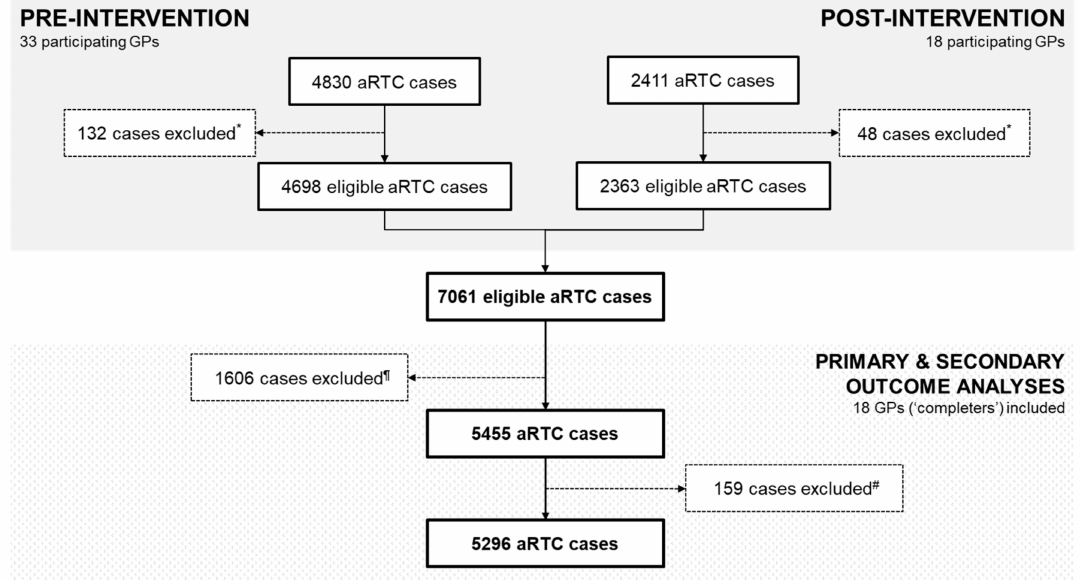
Figure 1. Flow chart of the total number of cases reported at pre- and post-intervention and those considered eligible for anal-